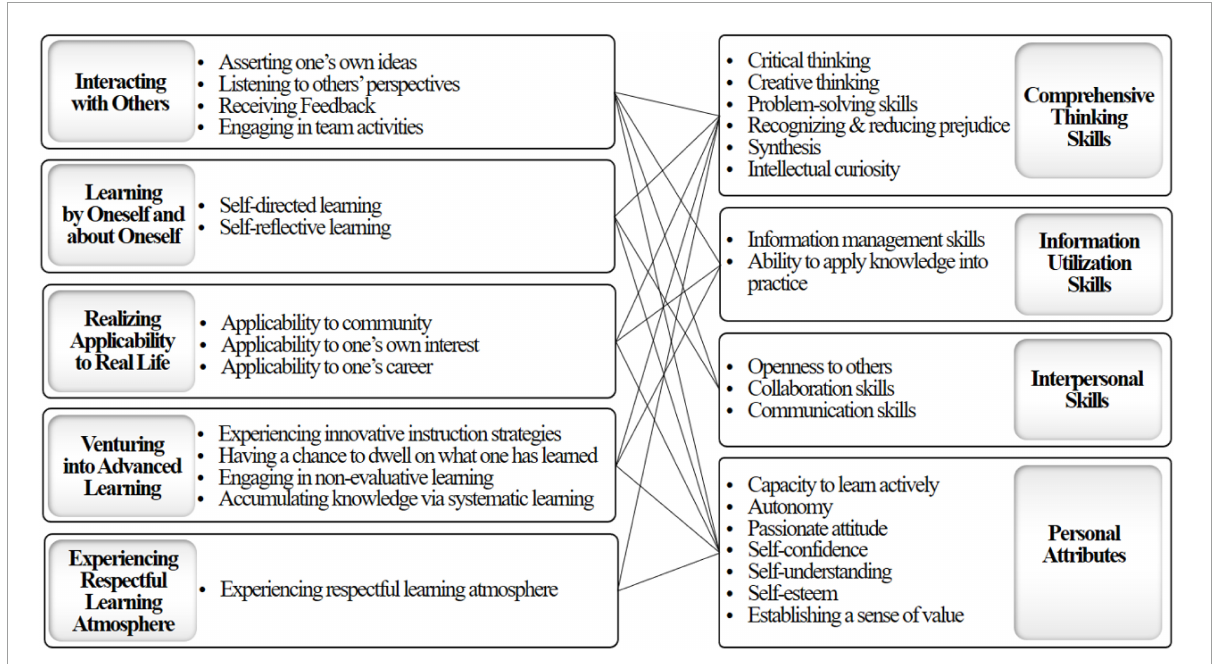
FIGURE1 Themes related to significant learning experiences and clusters of associated generic